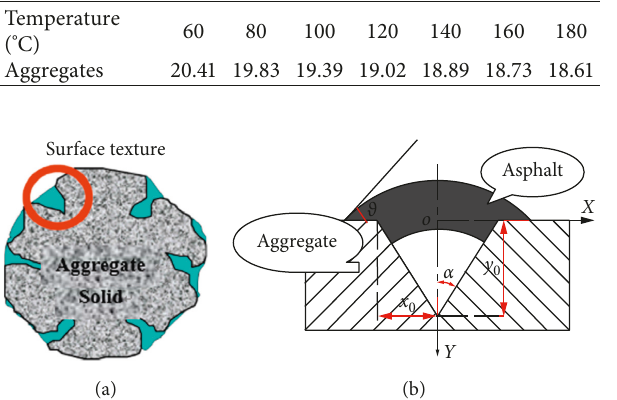
Figure 1: (a) Advancing angle when the drop is inflated. (b) Receding angle when the drop is deflated. Table 3: Contact angle between asphalt and aggregates at different temperatures ( ° ).